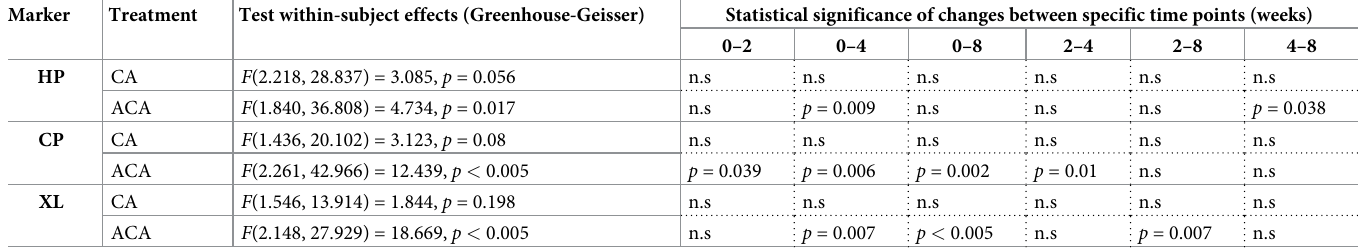
Table 3. Significance of changes in serum concentrations of hydroxyproline (HP), the C-terminal propeptide of procollagen I (CP), and cross-linked telopeptides (XL). These changes were measured within the ACA group and within the CA group across various time points. Marker